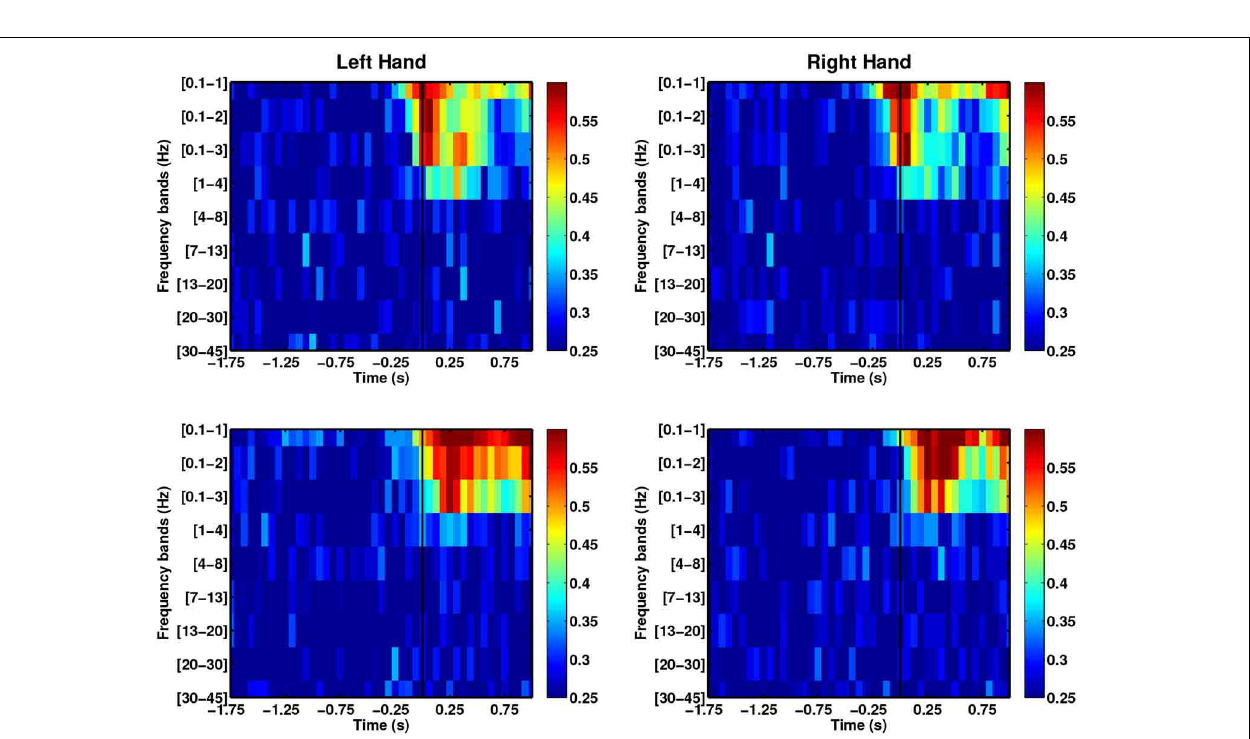
Frontiers in Neuroscience |